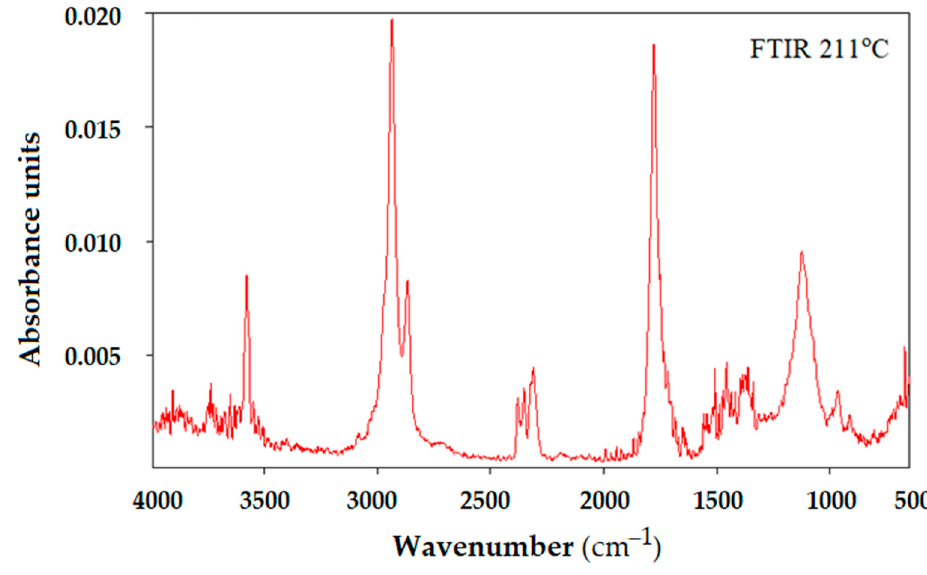
Figure 11. The identification of 10–undecenoic acid (UDA) in samples, at 211